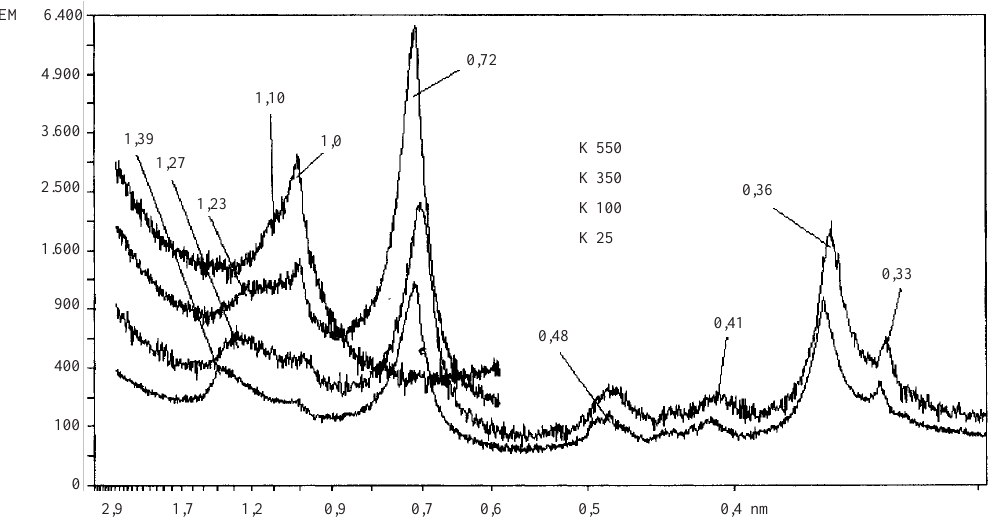
Figura 3. Difratogramas da fração argila orientada de amostras do horizonte A do perfil P1, tratadas com potássio e aquecidas a 25, 100, 350 e 550°C (K25, K100, K350 e K550